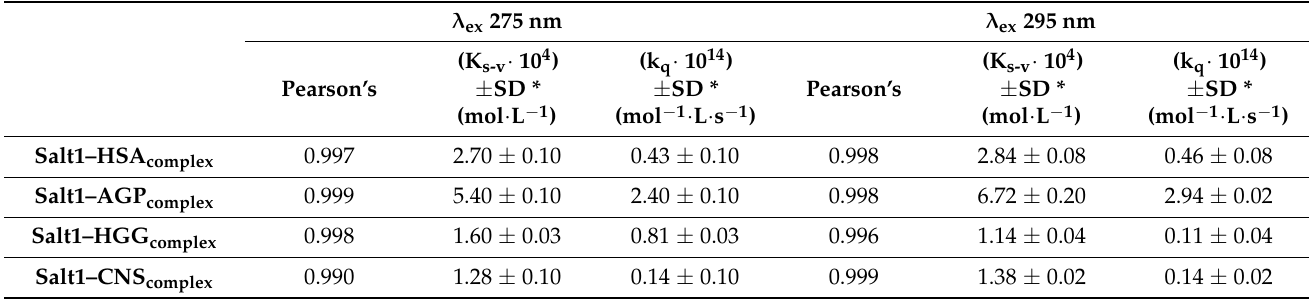
Table 5. The Stern–Volmer (K S-V ) and bimolecular quenching rate constants (k q ) for Salt1 in complexes with HSA, AGP, HGG and